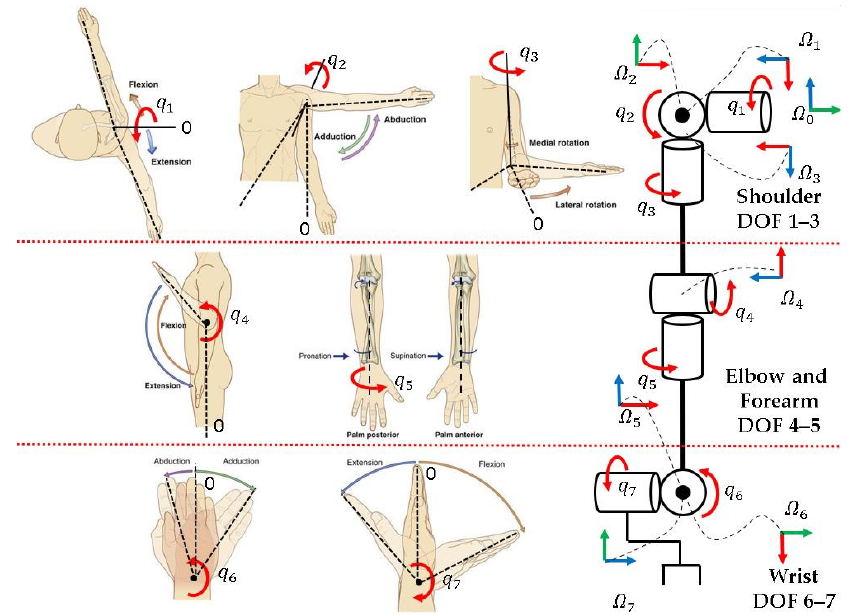
Figure 2. The basic motions ( left ) of the upper limb and its equivalent serial model ( right ). The figures of basic motions are adapted from [25].